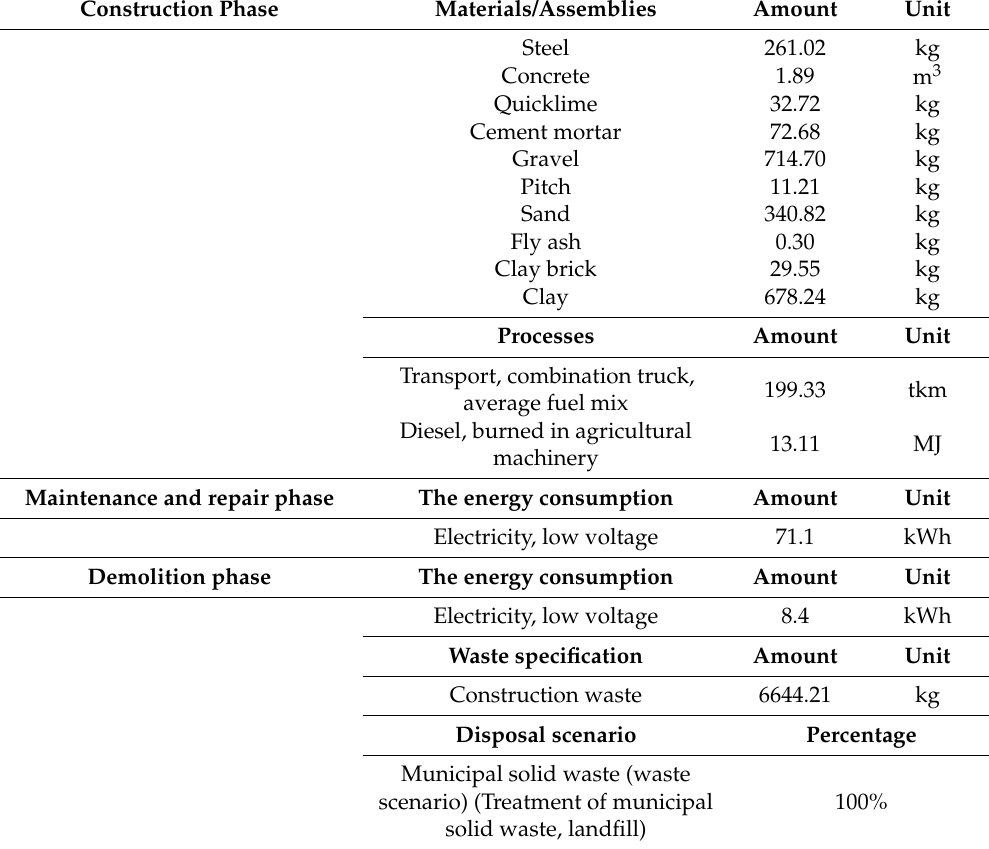
Table 2. The input data of EIA